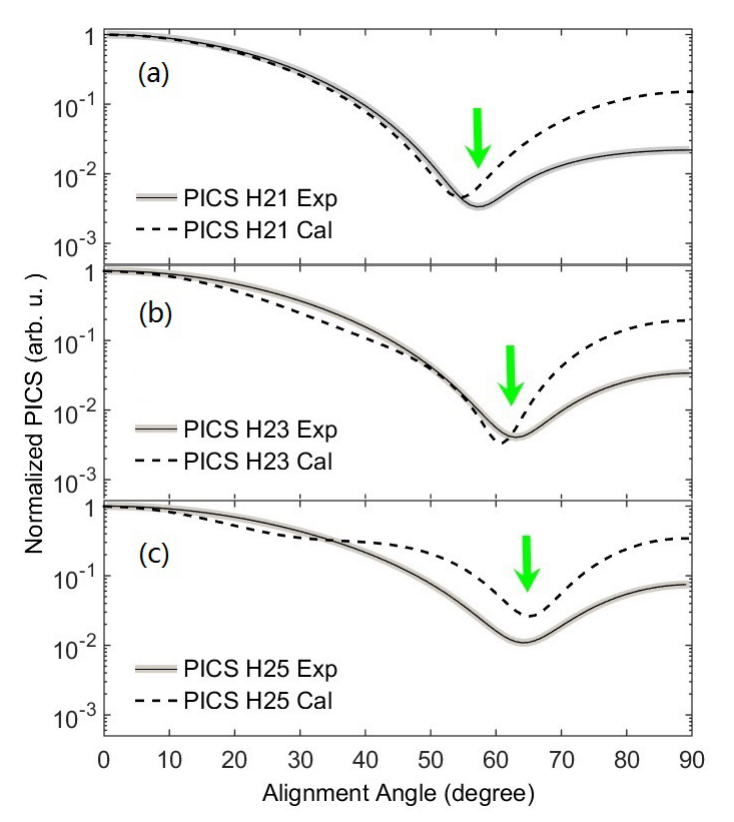
Figure 8. The normalized theoretical (dashed line) and experimental (solid line) angle-dependent differential PICS of the 21st ( a ), 23rd ( b ), and 25th ( c ) harmonic orders as functions of alignment. The green arrows indicate the angular minima for clarity. Reproduced with permission from